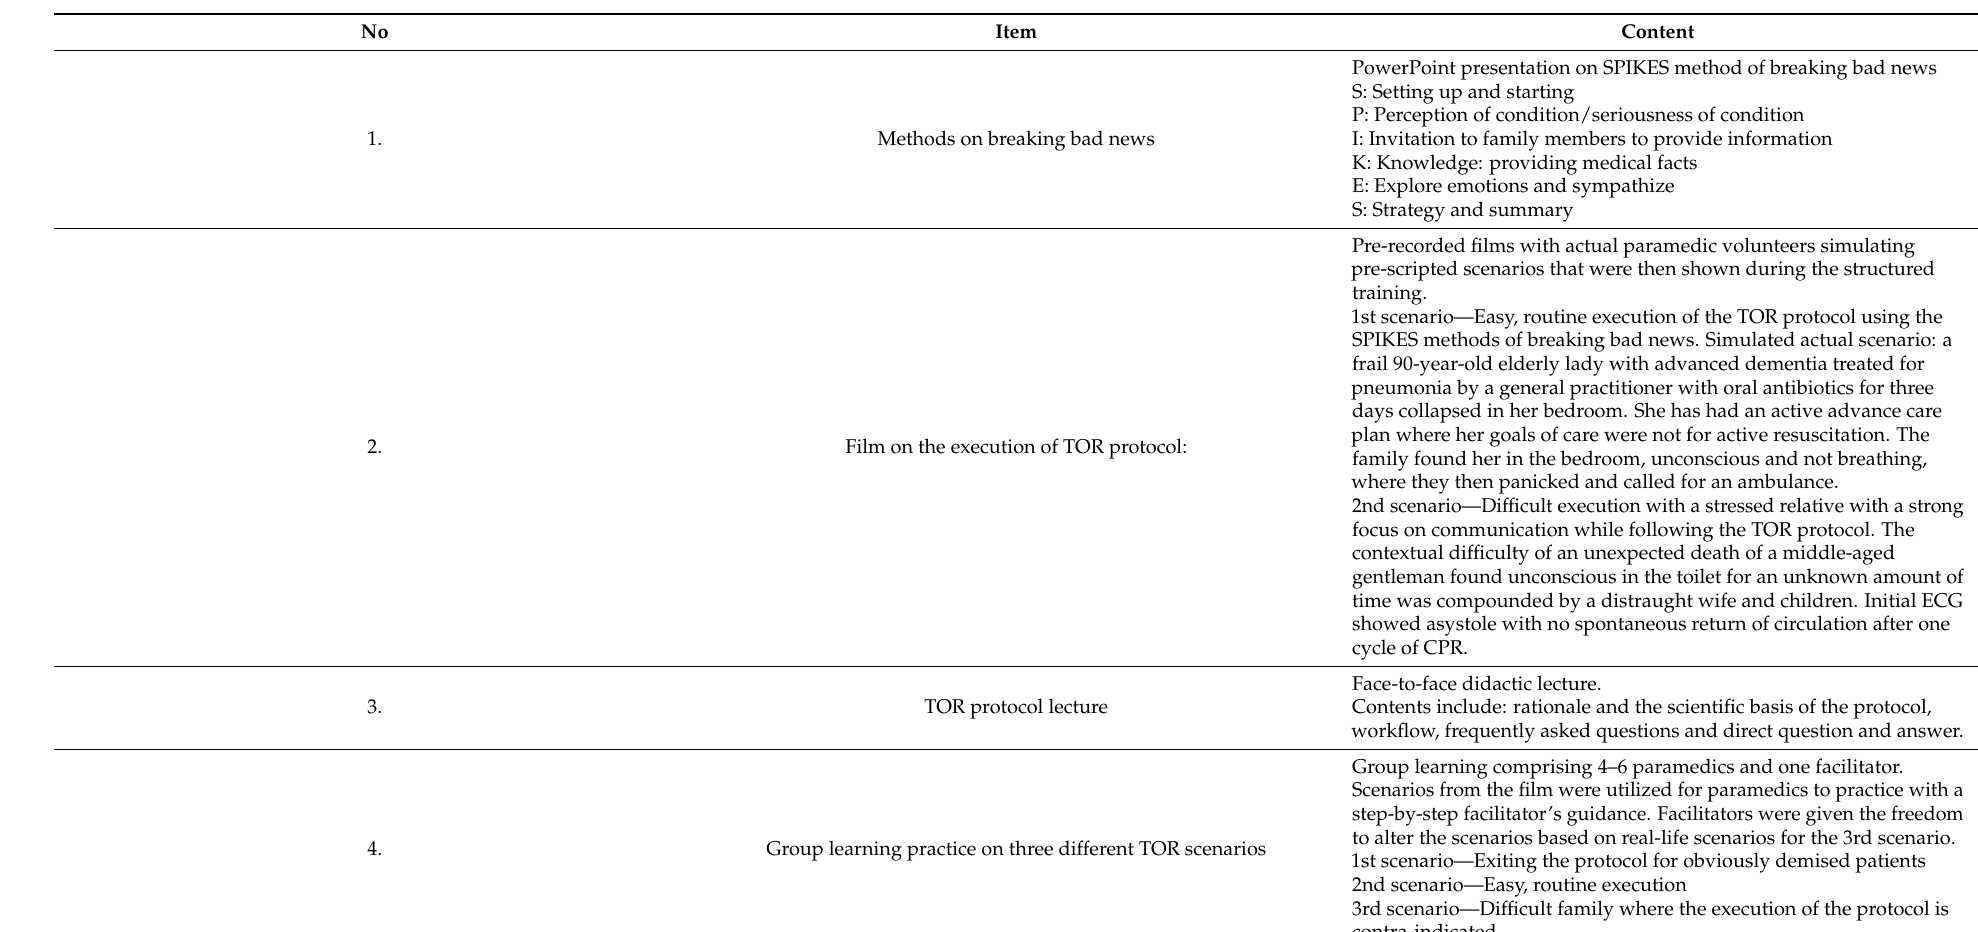
Table A1. Summary of Training